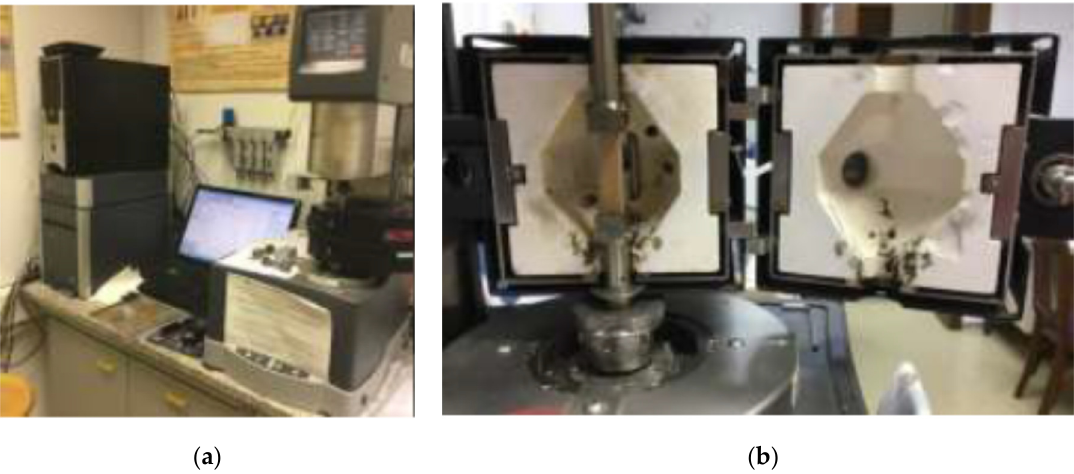
Figure 3. Rheometer ARES-G2 ( a ) and sample placed in torsion clamp and in temperature-controlled chamber ( b ).